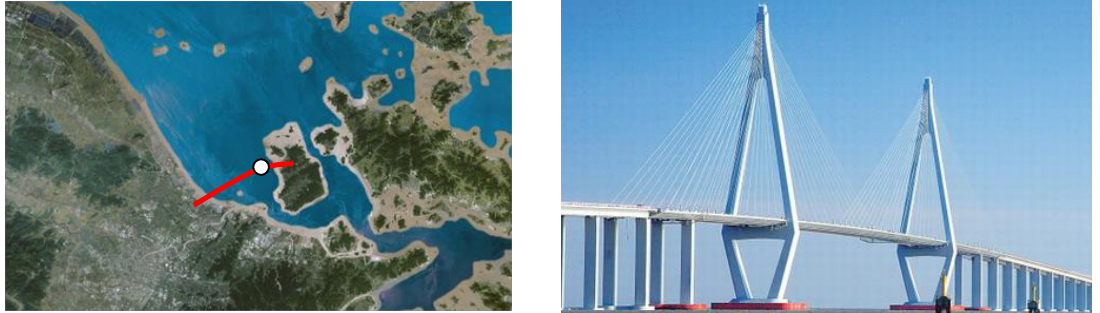
Figure 1. Location of the investigated bridge.